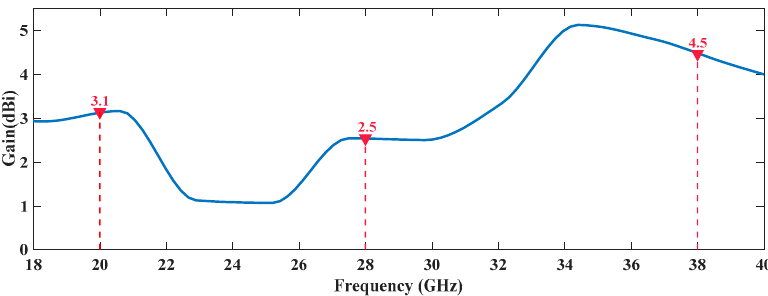
Figure 14. Gain Variation Over Frequency of the Tri-Band Antenna.